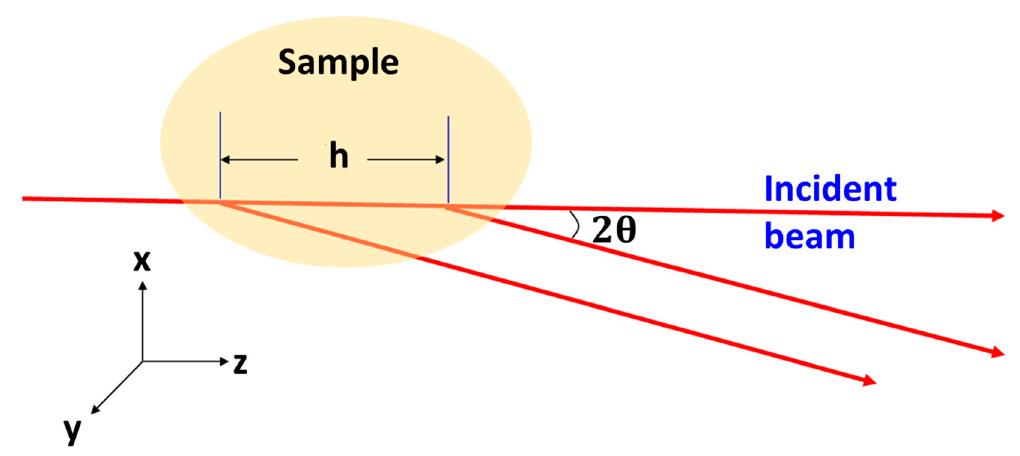
Figure 1. A schematic transmission small-angle X-ray scattering (tSAXS) diagram highlights the approximations invoked in typical small-angle scatterings. An incident beam with an infinitesimal cross-section and the scattered beams from two points within the sample are parallel as seen by the detector.